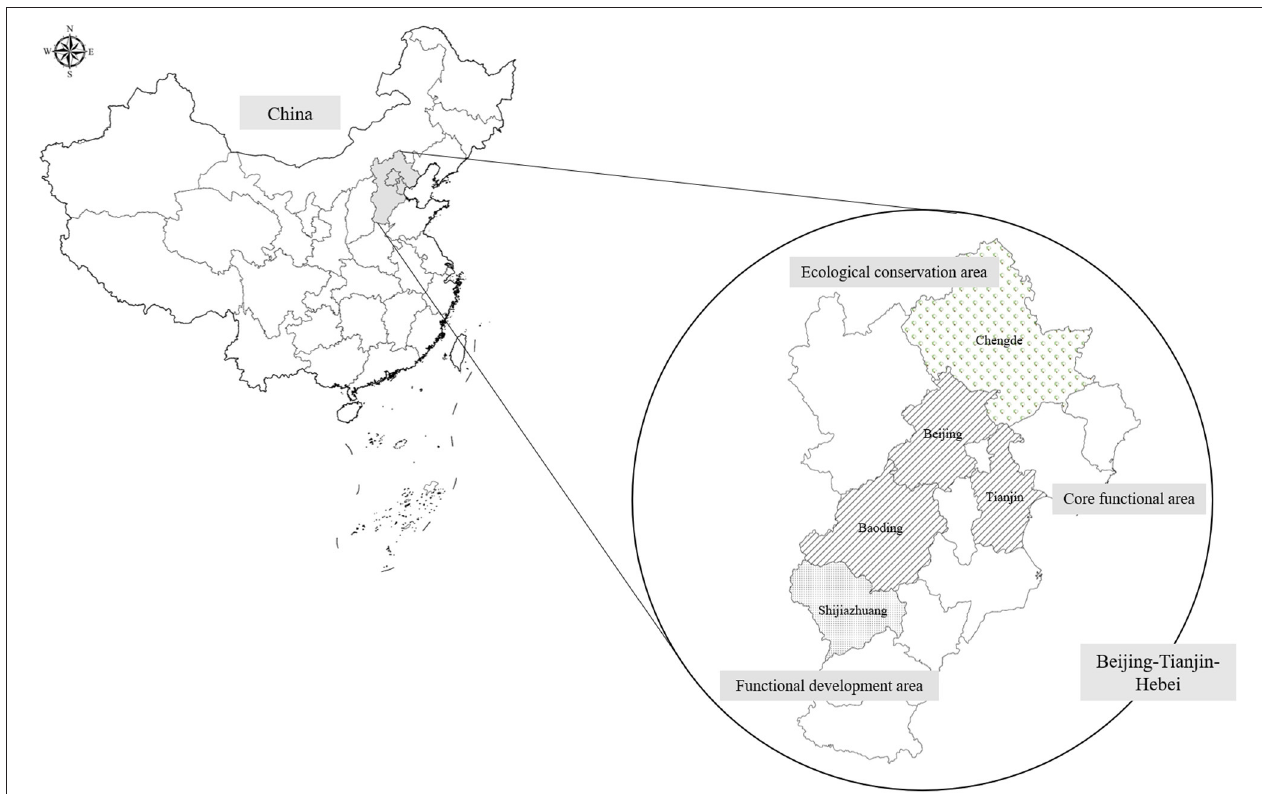
FIGURE 1 | Sampling set of